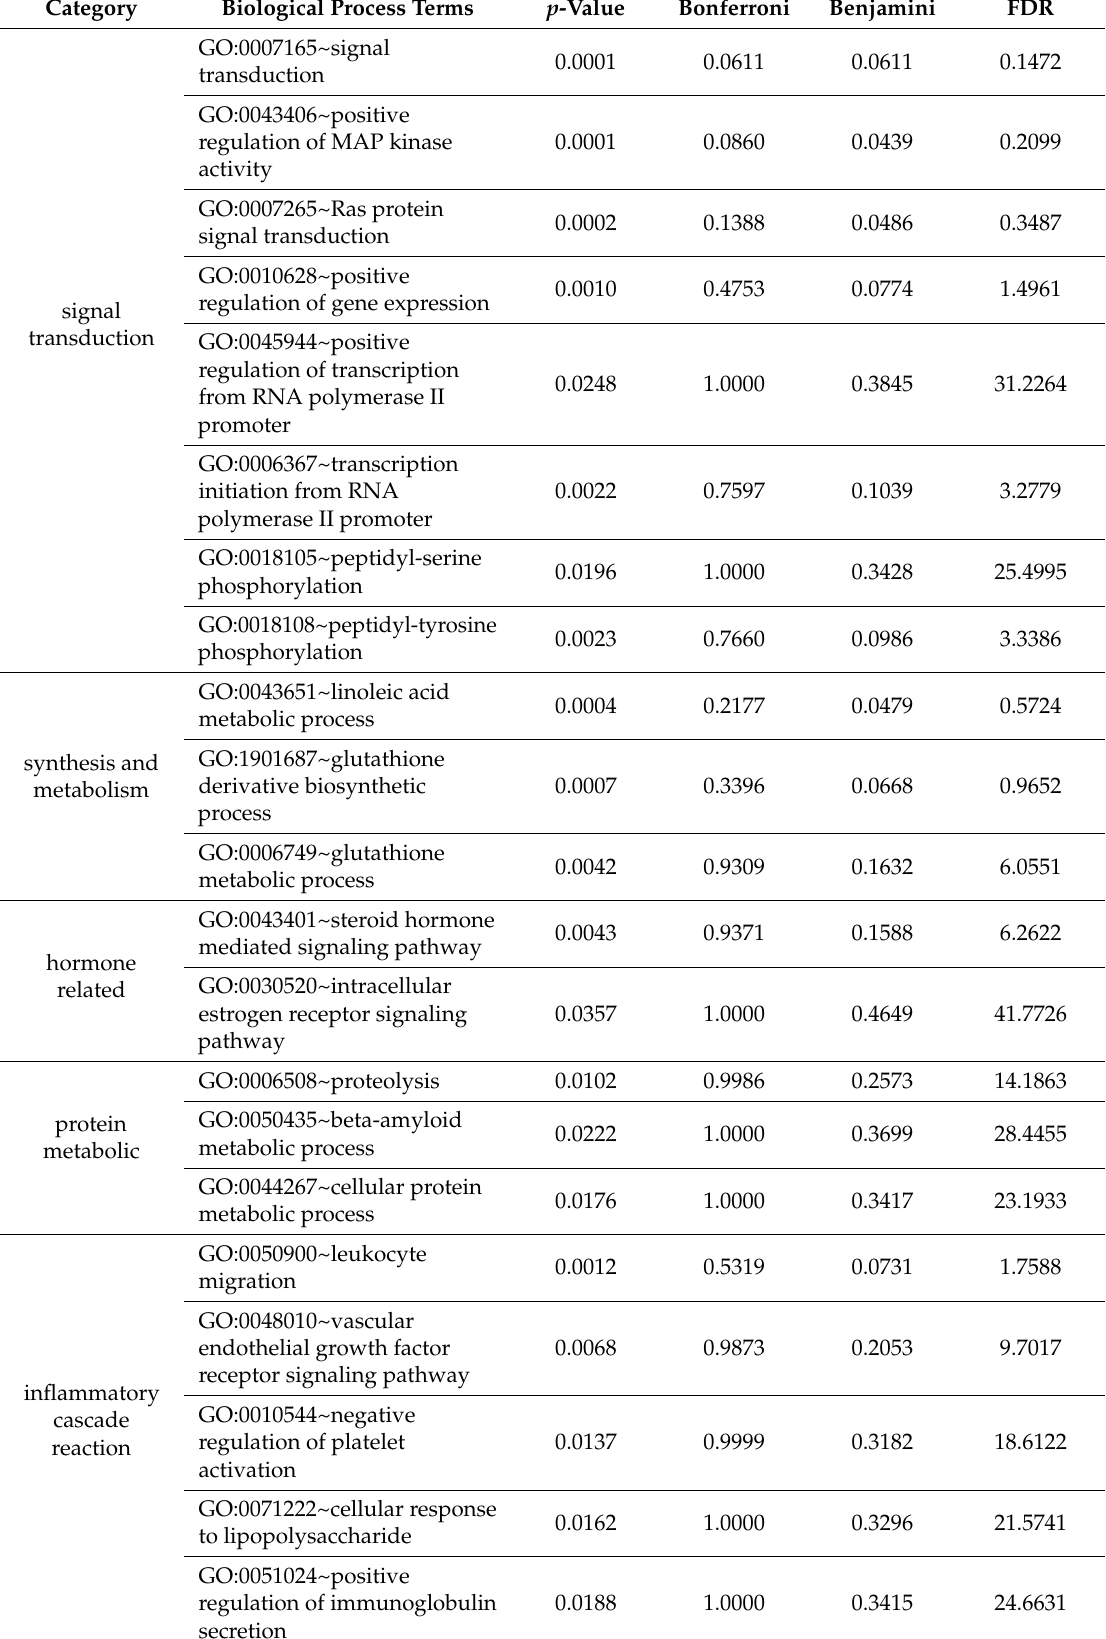
Table 1. The classification results of Biological Process